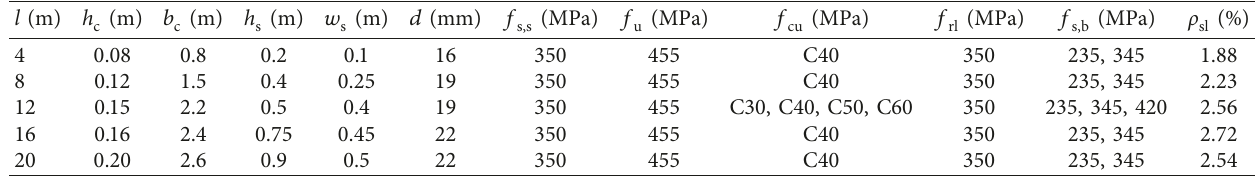
Table 4: Parameters of a steel-concrete composite beam.